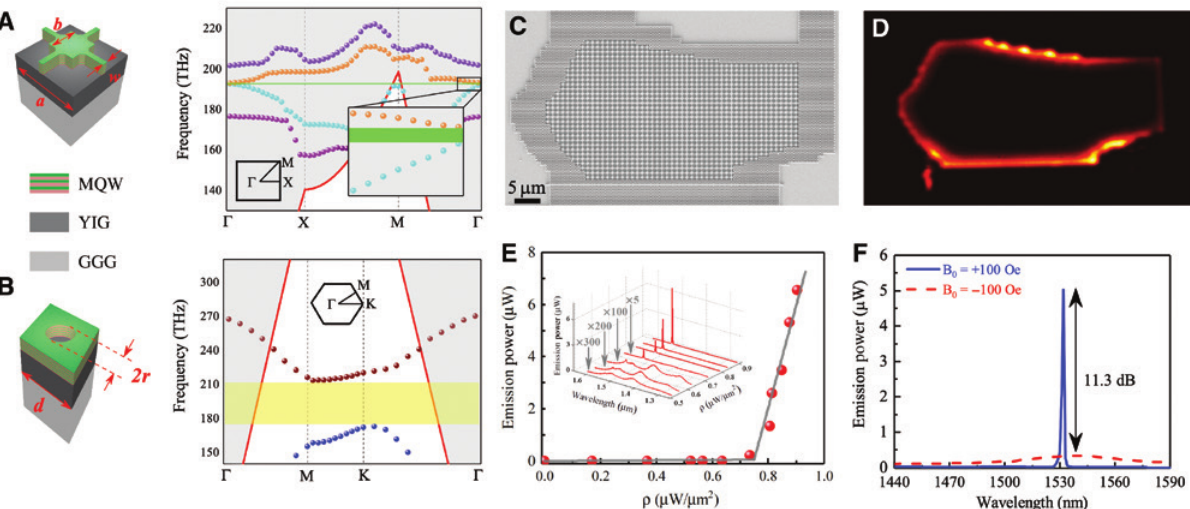
Figure 6: 2D topological photonic crystal laser with a static magnetic field. (A,B) 3D topological (trivial) bandgap unit cell structure and corresponding band diagram. (C) SEM image of the fabricated nanostructure with topological-trivial interface in the shape of flipped US map. (D) Top lasing image of (C) under static magnetic field. (E) Emission power of the laser as a function of pumping power. (F) Output power at one end of the coupling waveguide with the opposite direction of the magnetic field normal to the structure plane (replicated from Ref.